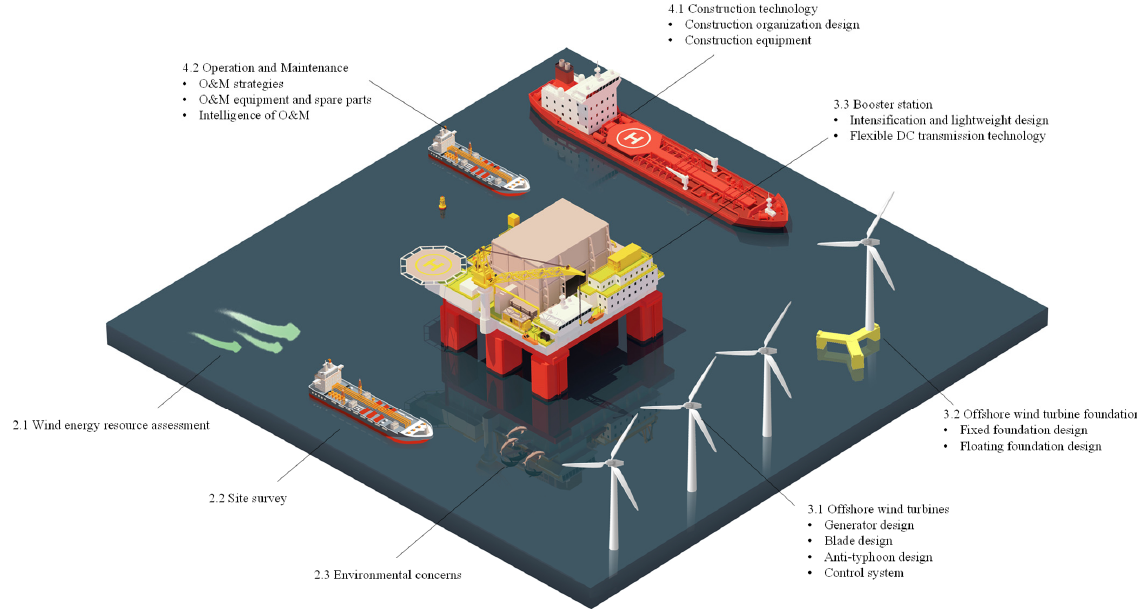
Figure 2. Estimated cost breakdown of China’s OWP projects. ( a ) Construction period; ( b ) operation period.